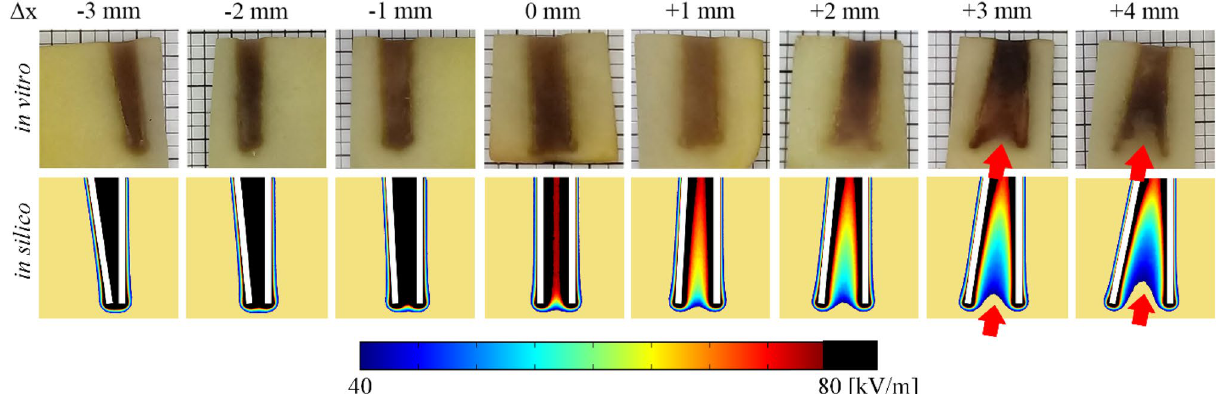
Figure 3. In vitro and in silico results of electric field distribution in Solanum tuberosum tissue. In vitro stained areas indicate tissue electroporation. The indentation effect (non-electroporated volume between the electrode pairs) can be observed from Δx = + 3 mm. The cut plane is shown in Fig. 1f highlight. The in silico cut planes were generated by COMSOL Multiphysics v.5.1 (COMSOL Inc., Stockholm, Sweden; https:// www. comsol. com/ comsol- multi physi cs).